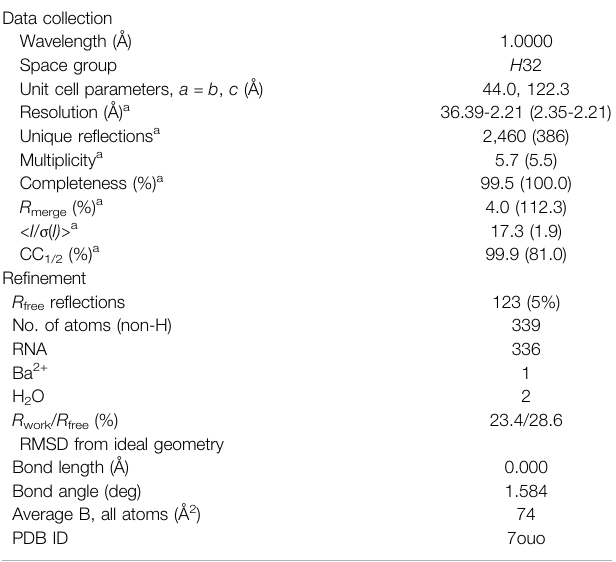
TABLE 1 | Diffraction data and re fi nement statistics.